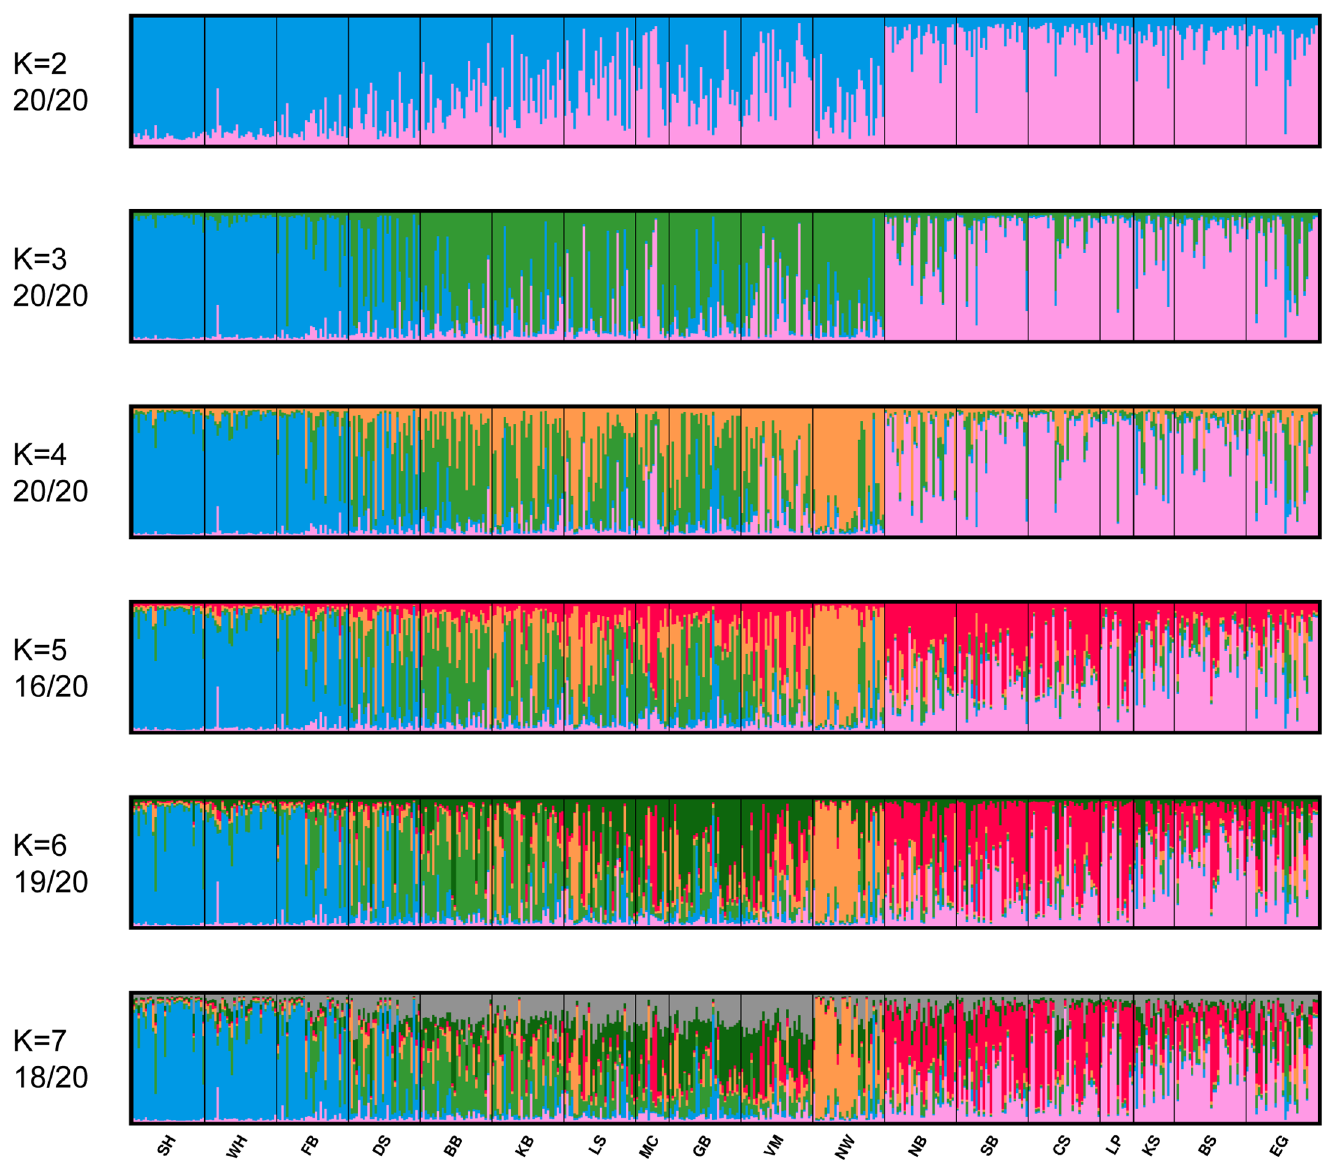
Fig 2. CLUMPAK-averaged S TRUCTURE outputs for 20 independent runs of K = 2 – 7, which were clustered and averaged using CLUMPAK. Numbers under each K-value indicate the proportion of runs that converged to the solution presented. Minority modes supported by at least two runs are provided in Fig A in S1 File. Management unit abbreviations are as in Table